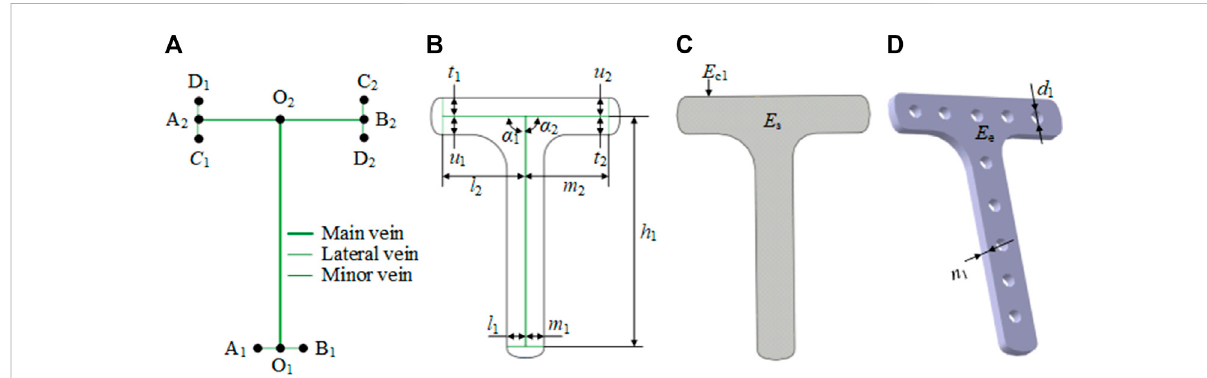
FIGURE 2 CharacteristicrepresentationoftheT-shapedboneplatebasedonthebionicveinstructure. (A) VeinstructureofT-shapedboneplate,contains mainvein,lateralvein,minorvein,andveinfeaturepoints.Theveinfeaturepointsincludethemainveinfeaturepoints(O 1 ,O 2 ),thelateralveinfeature points(A 1 ,B 1 ,A 2 ,B 2 ),andtheminorveinfeaturepoints(C 1 ,D 1 ,C 2 ,D 2 ). (B) SemanticparametersofT-shapedboneplate,mainlyreferstothelengthof veins and theangle between veins. (C) Abutted surfaceofT-shaped boneplate constructed by fi llingon thebasis ofpanel (A, B) . (D) Entity ofT- shaped bone plate generated by stretching on the basis of panel (C) .